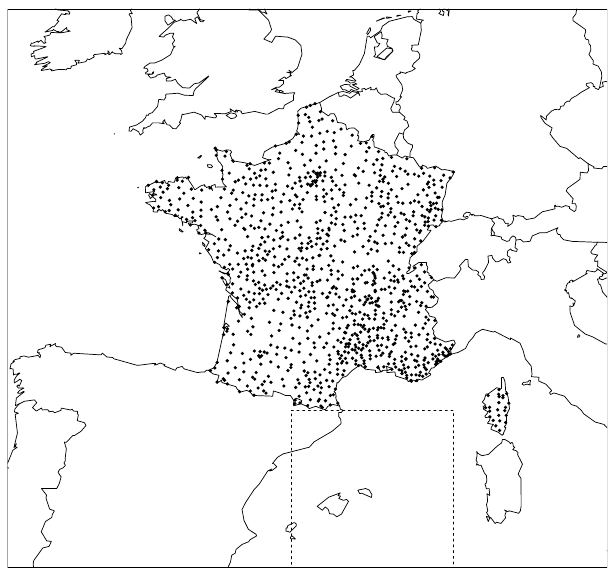
Figure 1. Operational AROME domain with a resolution of 2.5km. The markers indicate the temperature stations used for the monthly scores. The dashed line indicates the area of the case study of Sect.